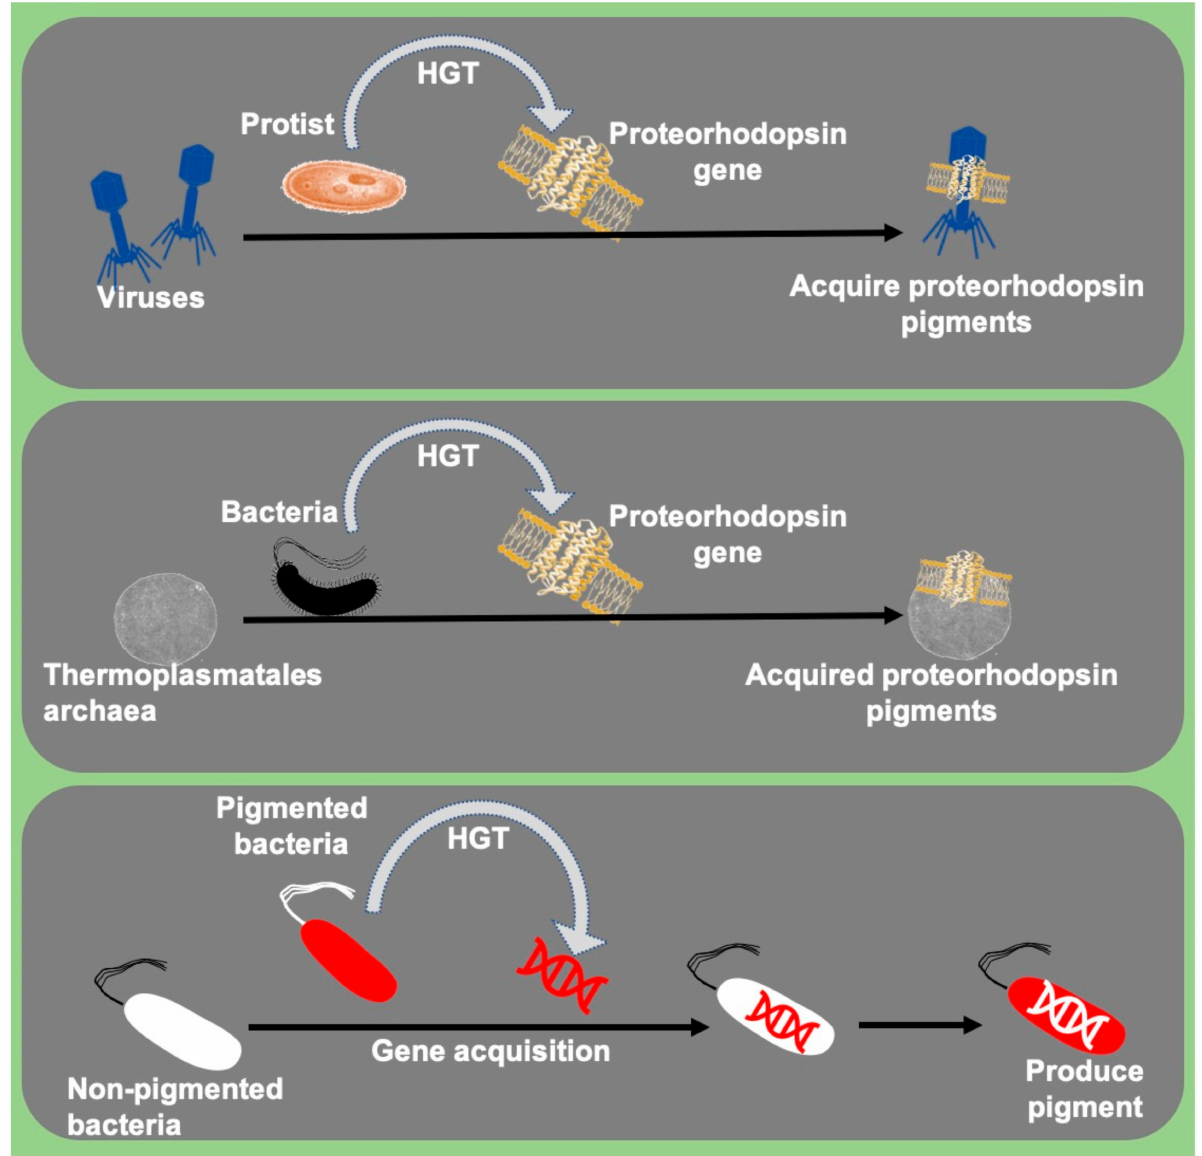
Figure 3. Acquisition of pigment encoding genes by Archaea, bacteria, and